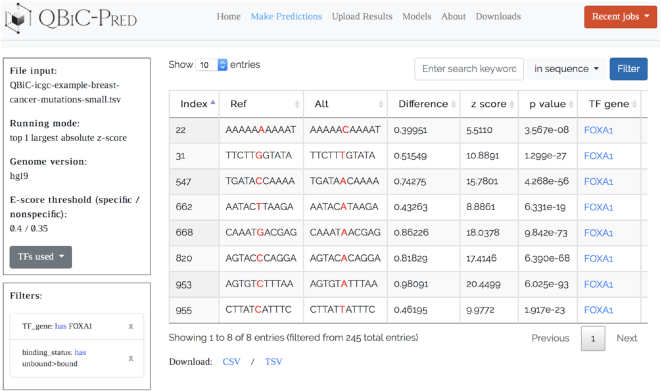
Web server results page for a sample mutation file containing ICGC breast cancer mutation data (the example use case ‘ICGC Breast Cancer Mutations - Small’, available in QBiC). Output results were filtered to include only the FOXA1 transcription factor, and only mutations that create TF binding sites, i.e. ‘unbound>bound’ mutations.